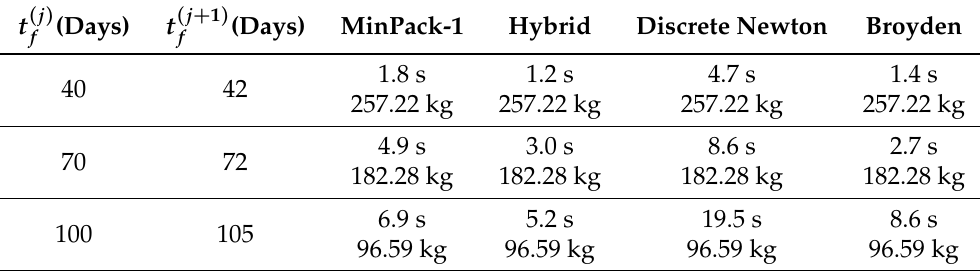
Table 2. Performance of the algorithm with different solvers (computation time and fuel consumption of the